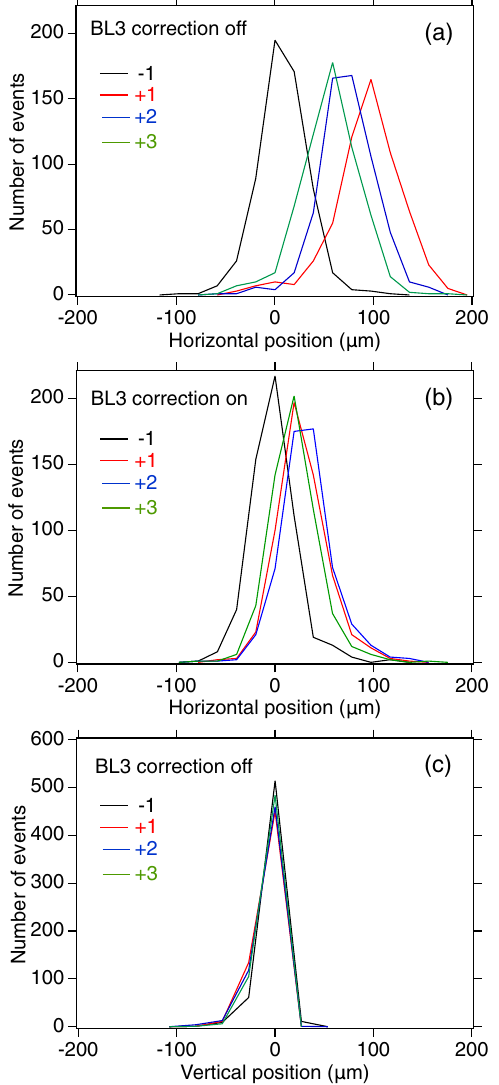
FIG. 6. Pointing stability of the XFEL photon beam observed at 40 m downstream of the BL3 undulator end. The data are collected for 6 h under the top-up injection. Black lines correspond to the last pulse before the injection, and red, blue, and green lines correspond to the first, second, and third pulses after the injection. Histograms of the horizontal beam position are plotted for without (a) and with (b) hysteresis correction. The kicker yoke hysteresis does not affect vertical stability as shown in